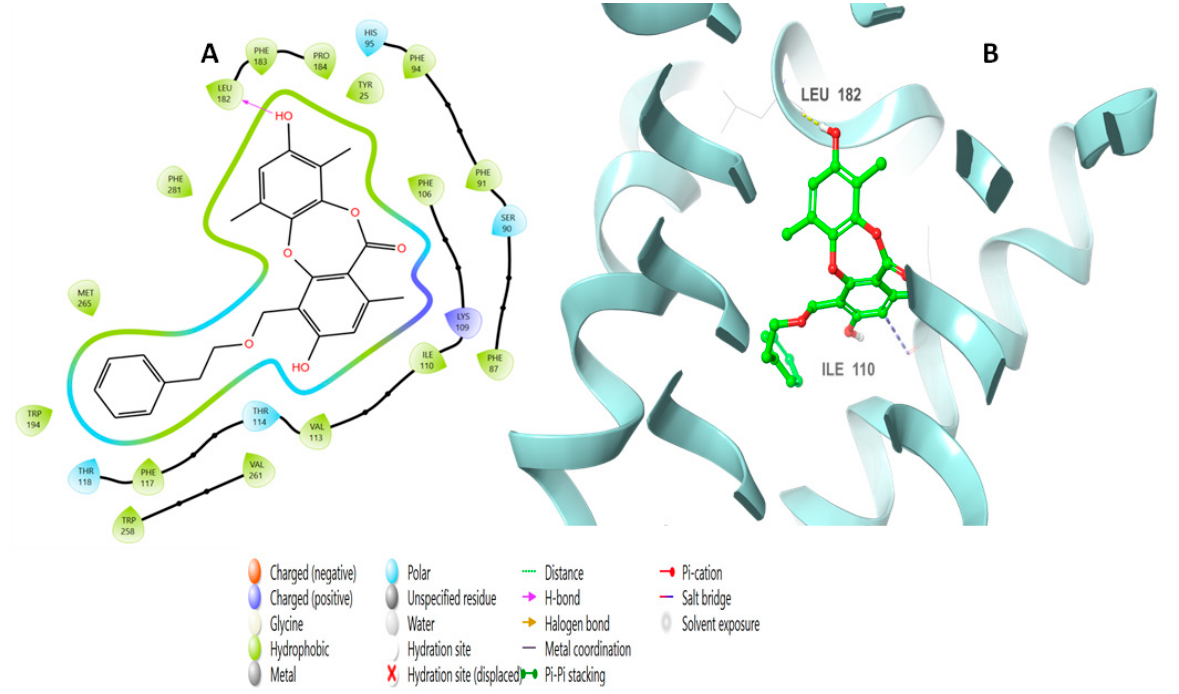
Figure 5. Putative binding mode of simplicildone J ( 10 ) at the binding site of CB2 receptor (PDB-ID: 6KPF). Simplicildone J ( 10 ) is displayed as green sticks. H bonds are displayed as yellow dotted lines, and ionic bonds as blue dotted lines. ( A ) Two-dimensional view; ( B ) three-dimensional view of CB2 complexed with simplicildone J ( 10 ).